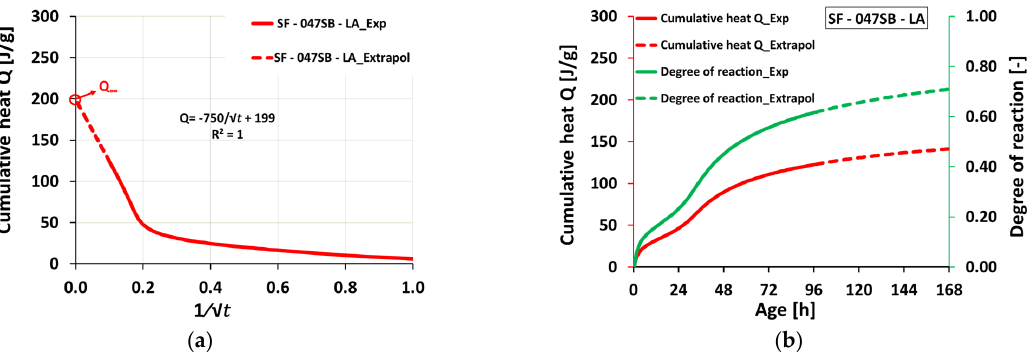
Figure 5. Extrapolation procedure for determination of the ultimate heat after [68] for mix SF— 047SB—LA: ( a ) cumulative heat as a function of 1/ √ t ; ( b ) evolution of cumulative heat, as well as the respective degree of reaction, including the actual measurements. Table 4. Estimated ultimate heat release Q (cid:2998) through extrapolation of calorimetry results.